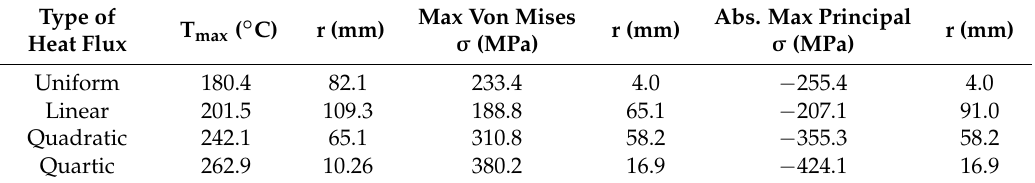
Figure 7. Comparison of temperatures, and stresses for four types of heat flux, t = 10.26 s. ( a ) Uniform, ( b ) Linear, ( c ) Quadratic, ( d ) Quartic. Table 1. Maximum temperatures, positions and stresses for four types of heat fluxes at t = 16.26